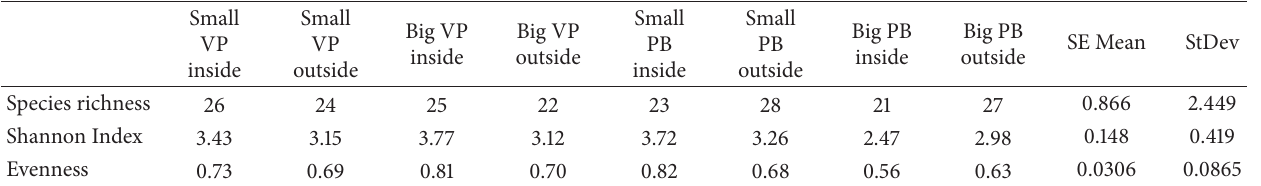
Table 4: Species richness, diversity, and evenness from inside and outside crown zones of trees with different sizes and the open field, with their standard deviation (StDev) and Standard Error of the Mean (SE Mean). PB: P. biglobosa ; VP: V. paradoxa .